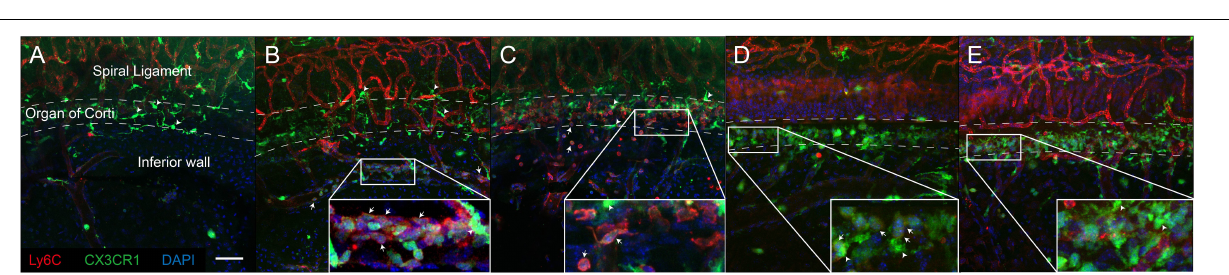
FIGURE 3 | Infiltrated monocytes transformed into macrophages within 5 days after acoustic stimulation. Concatenated contour plots (merging four biological replicates for each time point) showing CD11b + Ly6G – F4/80 + CX3CR1 + cells at different time points after acoustic overstimulation. Black contour : cochlea sample, red contour : control peripheral blood sample, dots : center of each population.